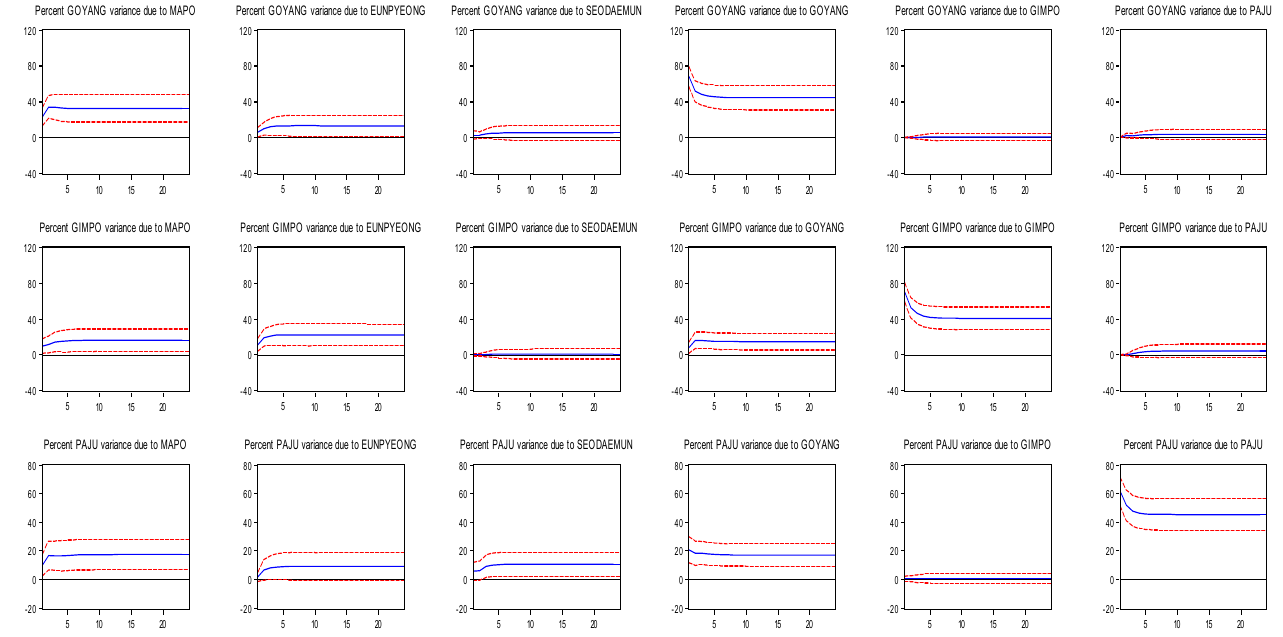
Figure 6. Variance decomposition analysis of the jeonse market in the Gyeongeui region.